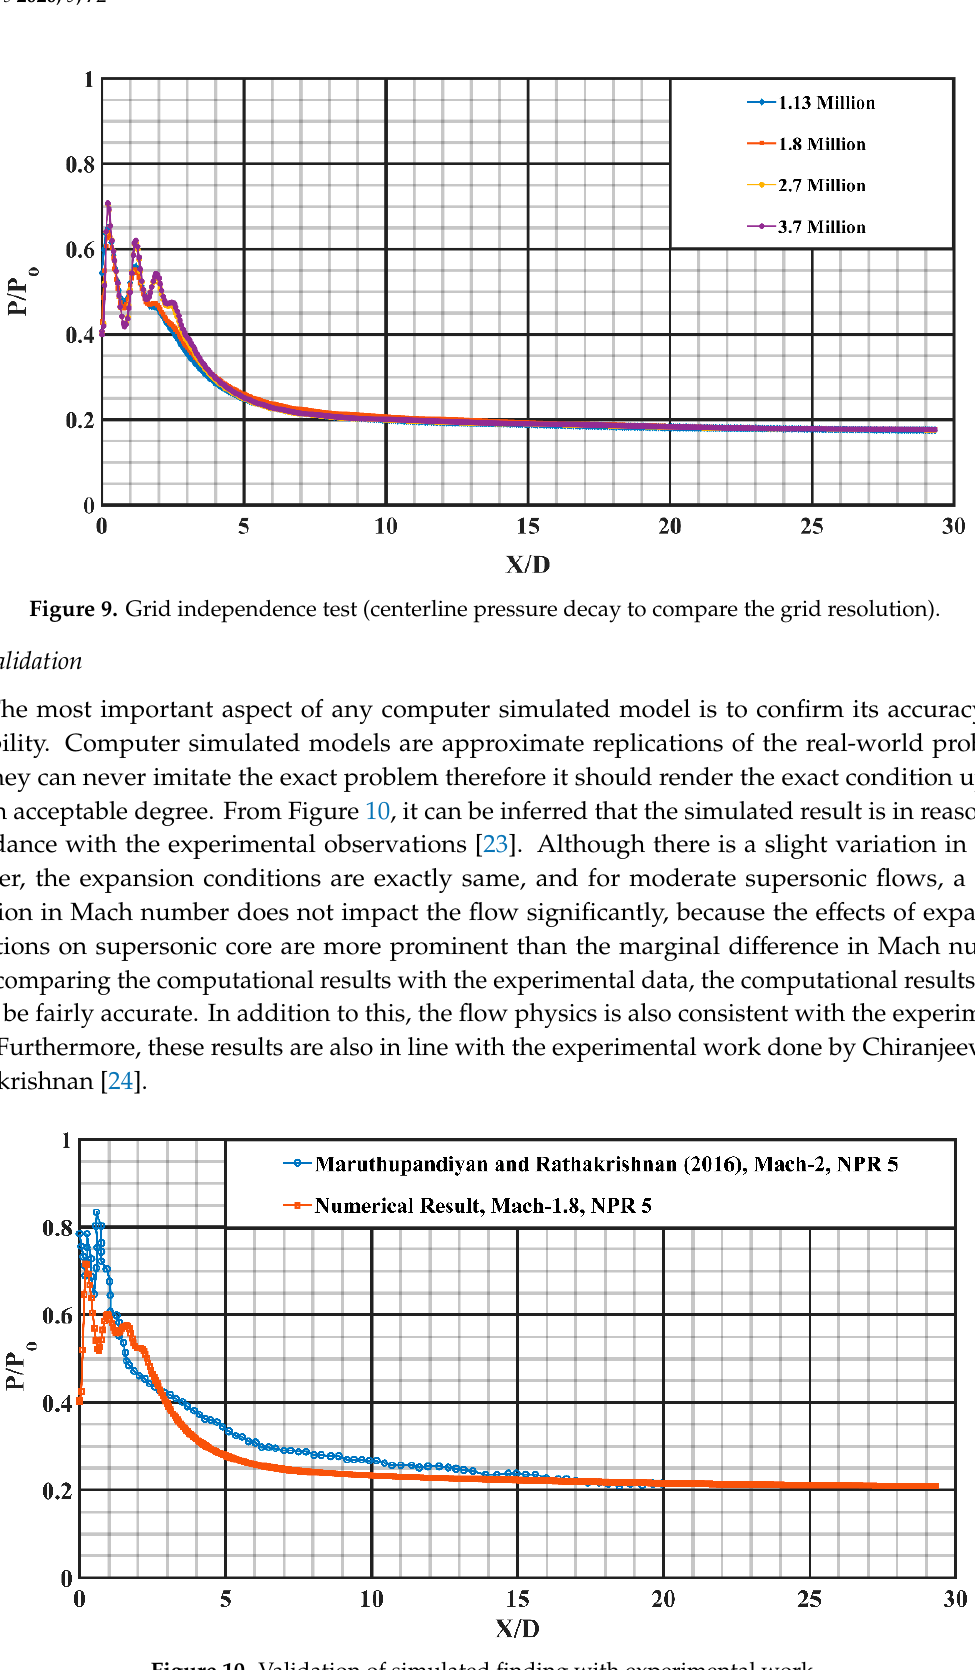
Figure 10. Validation of simulated finding with experimental work.